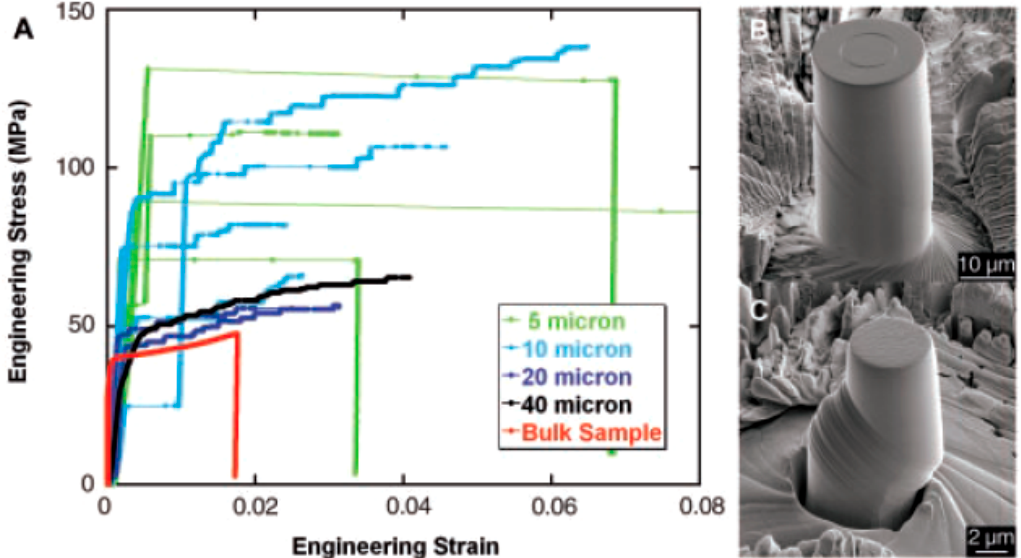
Figure 13. Size-e ff ect in plastic deformation of single-crystal pure Ni micropillars of < 134 > orientation Figure 13. Size-effect in plastic deformation of single-crystal pure Ni micropillars of <134> orientation at room temperature: ( A ) Stress-strain curves for di ff erent sample-sizes and ( B ) A scanning electron at room temperature: ( A ) Stress-strain curves for different sample-sizes and ( B ) A scanning electron microscopy (SEM) image of a 20- µ m-diameter micropillar deformed to ~4% strain and ( C ) A SEM microscopy (SEM) image of a 20- μm -diameter micropillar deformed to ~4% strain and ( C ) A SEM image of smaller, 5- µ m-diameter micropillar, which achieved a rapid strain burst of ~19% strain in less image of smaller, 5- μm -diameter micropillar, which achieved a rapid strain burst of ~19% strain in than 0.2 s. Reproduced with permission from [81]. Copyright 2004, less than 0.2 s. Reproduced with permission from [81]. Copyright 2004, AAAS.